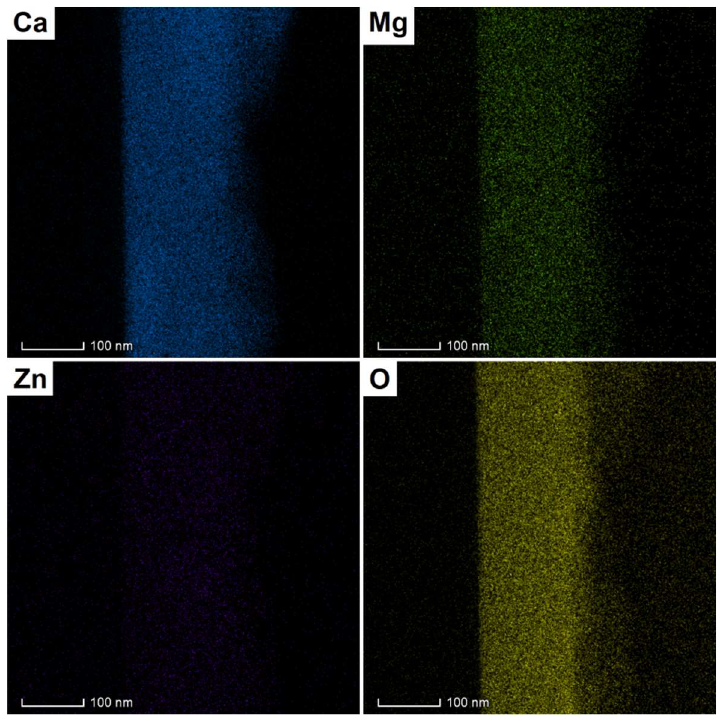
Figure 5. Electron energy loss spectroscopy (EELS) mapping of Film A.